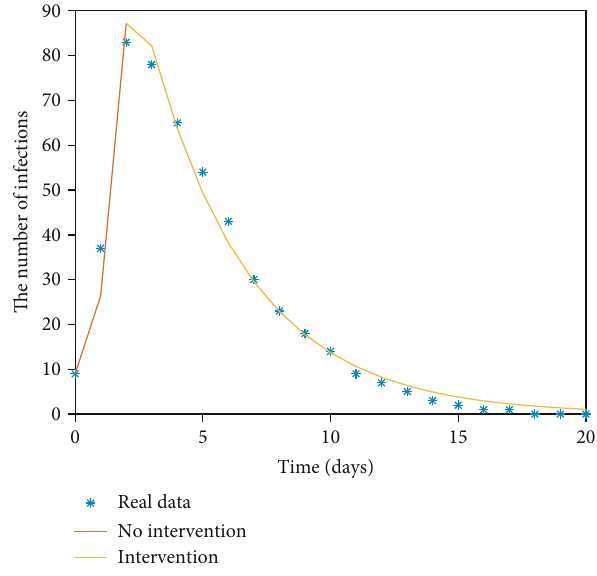
Figure 2: Quantity of the Norovirus infections I ð t Þ compared with the numerical results of one-term fractional-order SEIAR model (16) obtained by the MGAM method and g = 3 : 1922